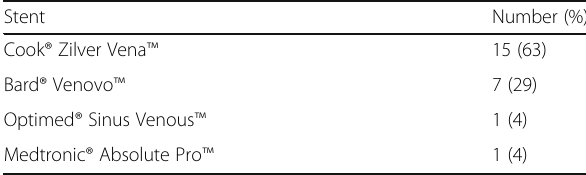
Table 2 Brands of stents used in the treatment of